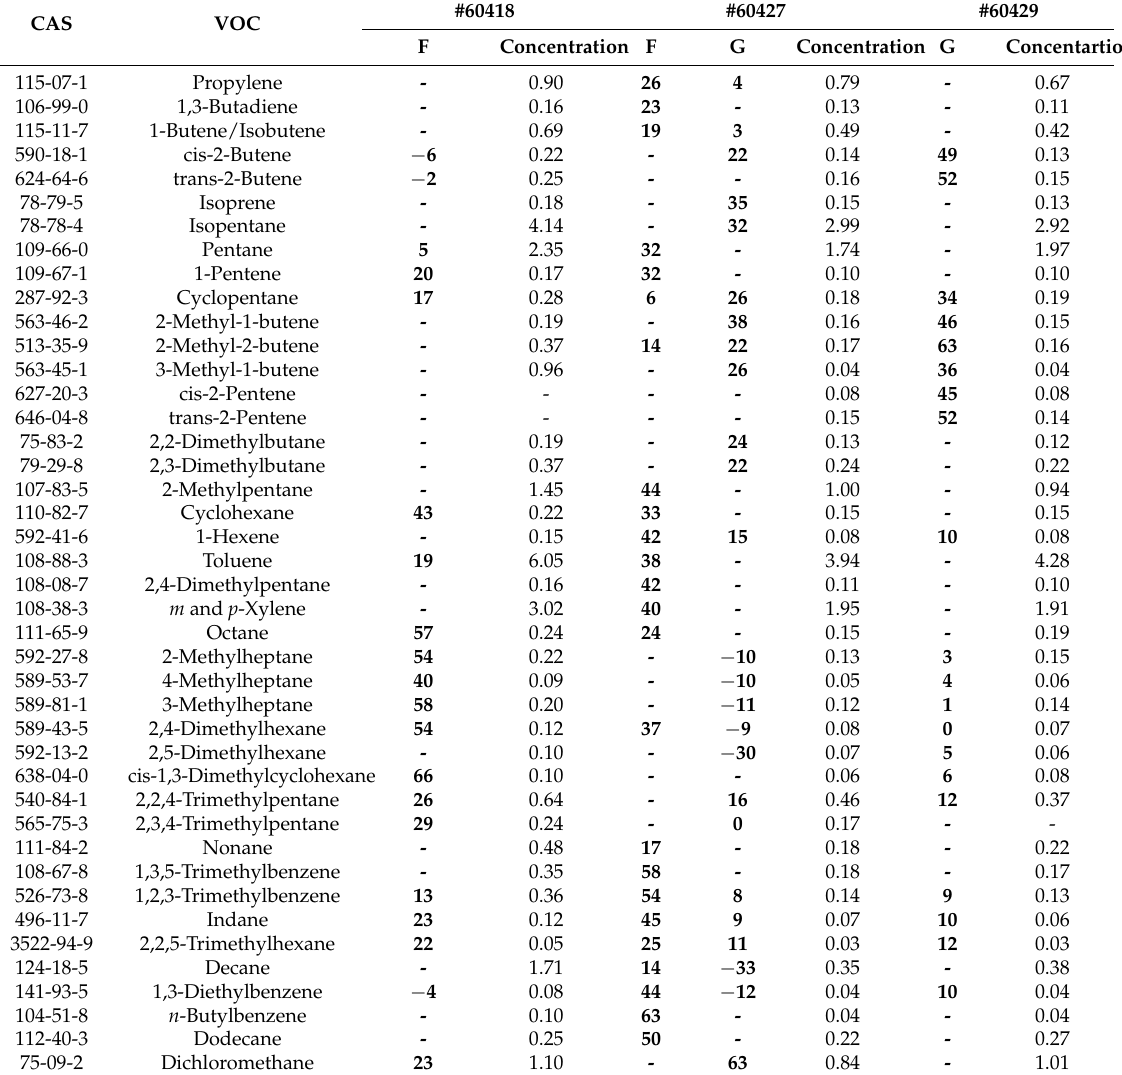
Table 9. Profiles of two industrial sources remotely detected at stations #60418, #60427, and